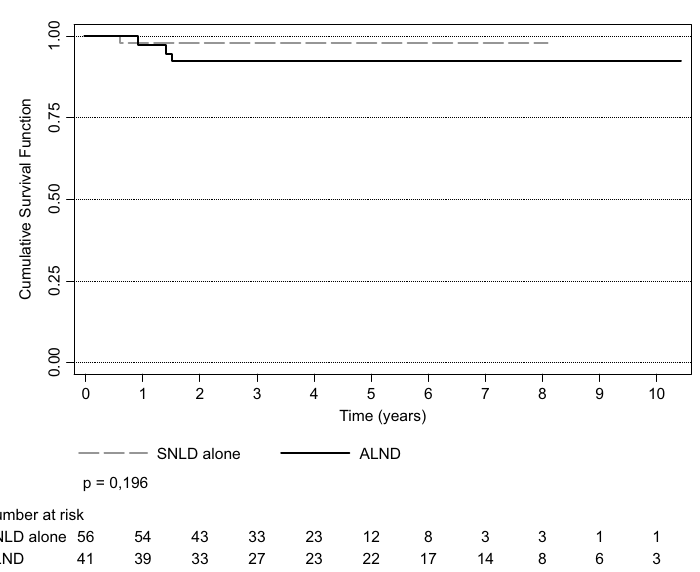
Figure 4. Survival after locoregional recurrence. SLND sentinel lymph node dissection, ALND complete axillary lymph node